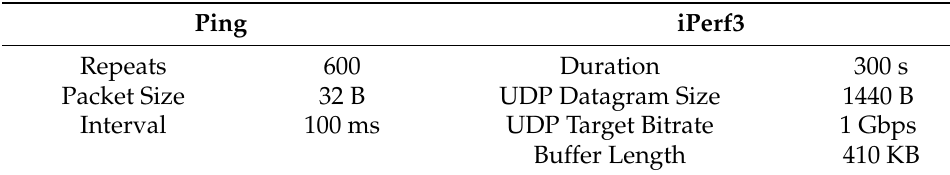
Table 1. Ping and iPerf3 parameters.